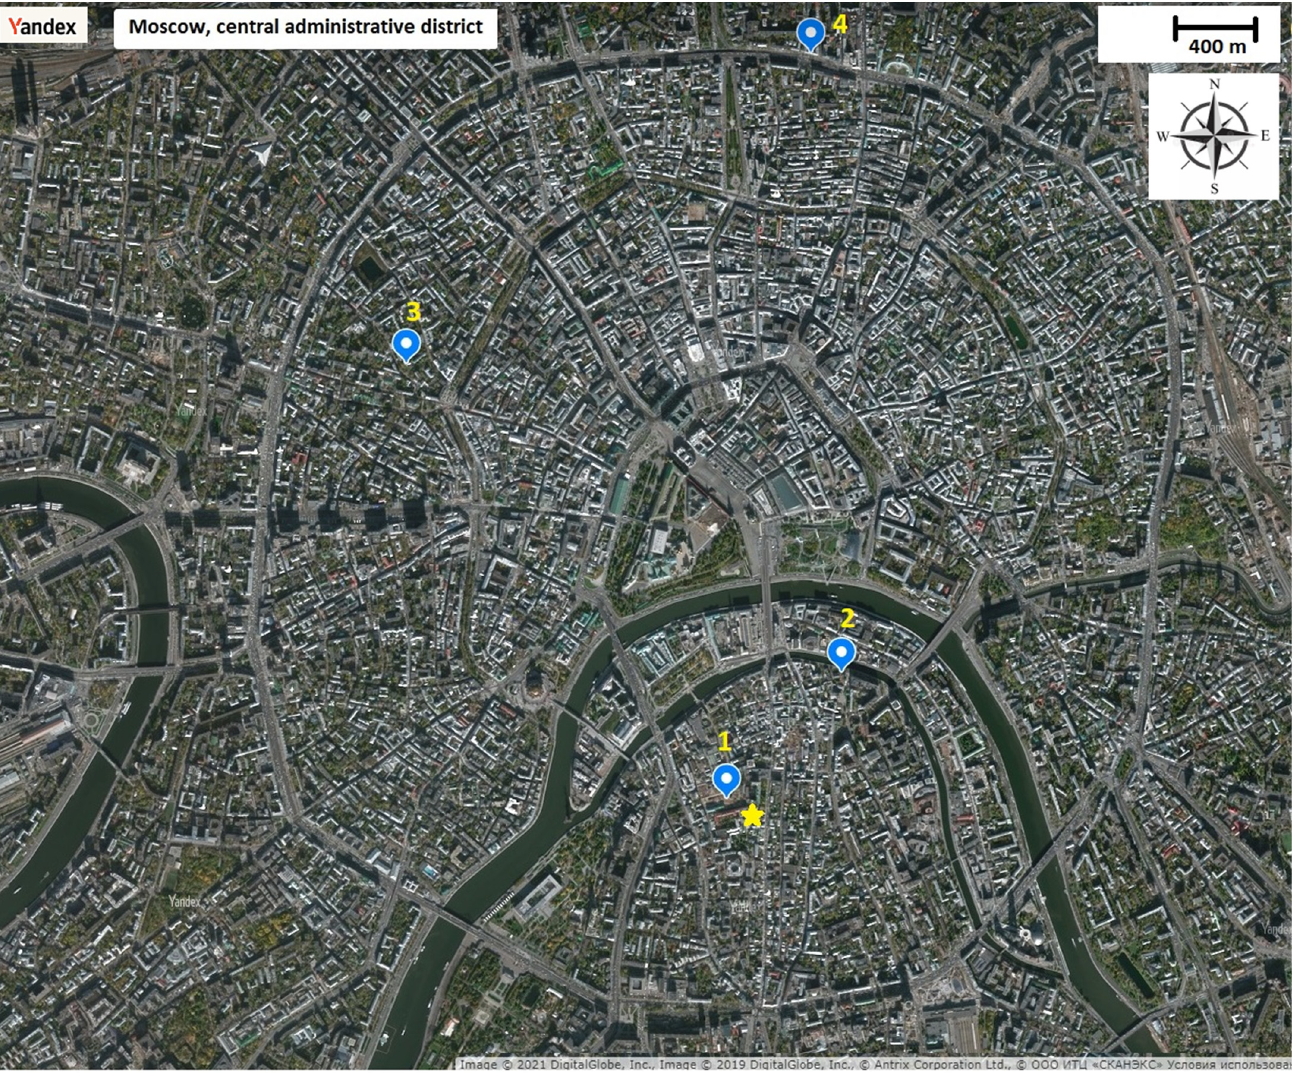
Figure 1. Location of the IAP observation point (asterisk), local anthropogenic source ( 1 ), Balchug meteorological station ( 2 ), station Spiridonovka (Spir) of the State Research and Development Institution “Mosecomonitoring” (MEM) ( 3 ) and station Sukharevskaya (Sukhar) MEM ( 4 ) in the center of Moscow.